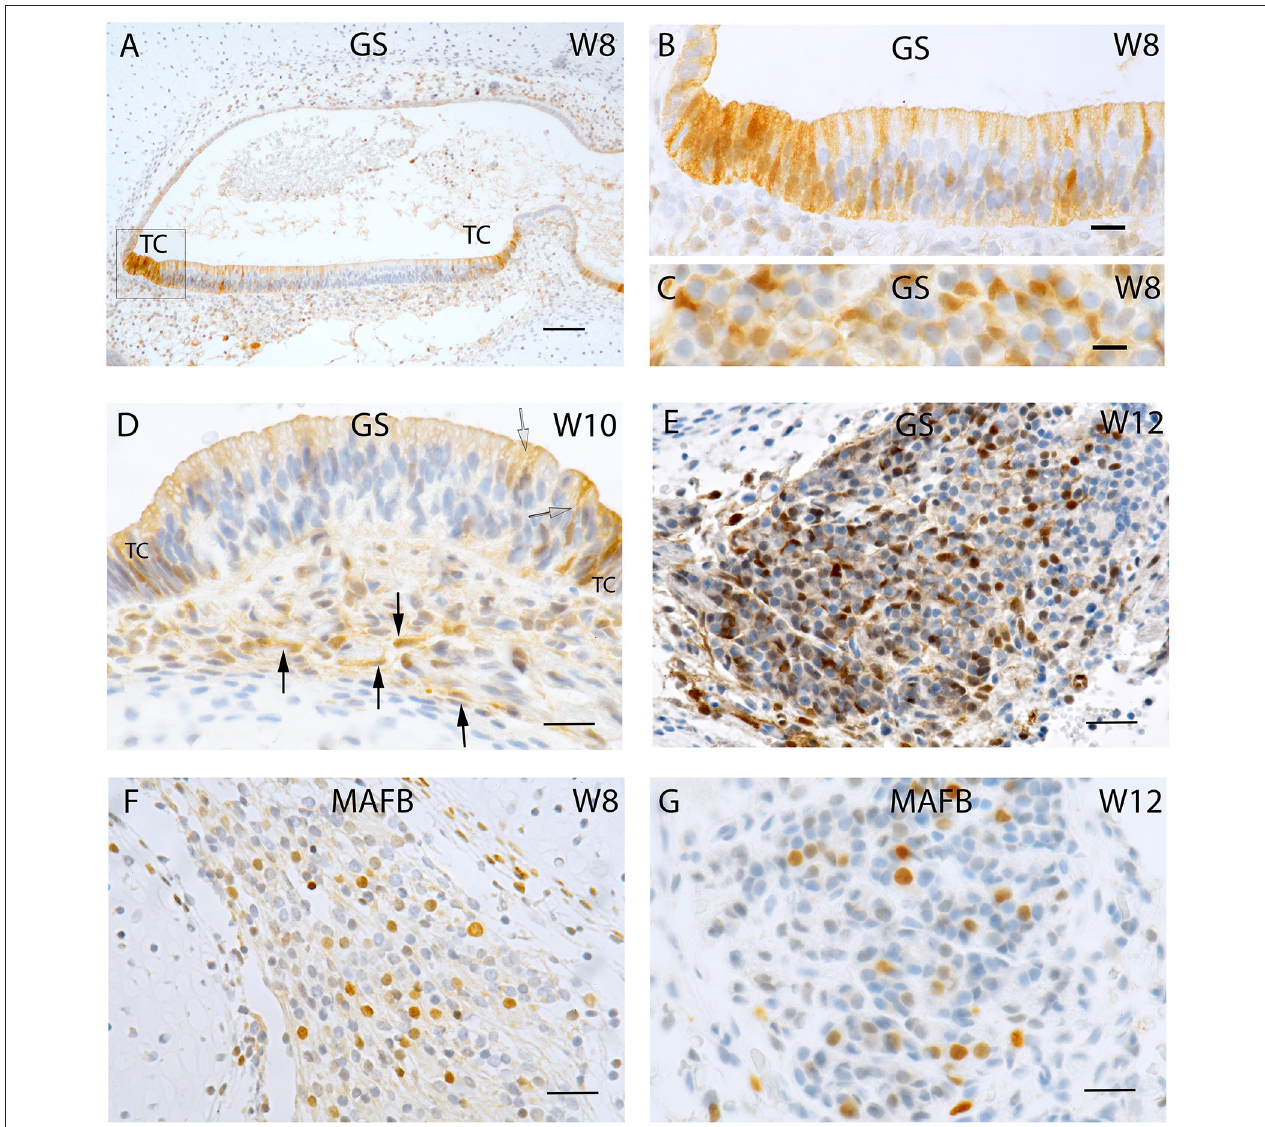
FIGURE 2 | Sections of the developing fetal VO between W8 and W12. (A) Glutamine synthetase (GS) expression in the (A) Utricle at W8 in the transitional cells (TC) and the supporting cells of the otic epithelium. (B) Higher magnified view of the framed area in (A) of the TC and neighboring sensory epithelium where the supporting cells exhibit strong GS immunoreactivity while the hair cells are void of staining. (C) Higher power view of the VG from W8 were only the satellite glial cells shows strong GS immunoreactivity. (D) GS immunoreactivity in a crista ampullaris at W10 were the TC and supporting cells in the sensory epithelium (open arrow) are positive for this marker. Non-myelinating Schwann cells (arrows) under the ampullary organs also show immunoreactivity for this marker. (E) GS in the neurons at W12. Strong immunoreactivity is visible in the satellite glial cells at this stage. (F) MAF B immunoreactivity is present in a subpopulation of VG cells at W8. (G) MAF B again stains nuclei in a subpopulation of ganglion cells in a manner reminiscent of W8. Scale bar: 50 µ m (A) , 10 µ m (B,C) , and 12 µ m (D–G) .